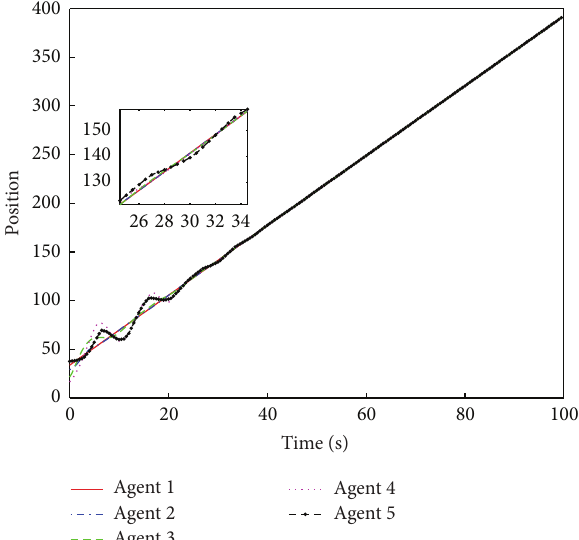
Figure 6: Consensus of position for high-order system.